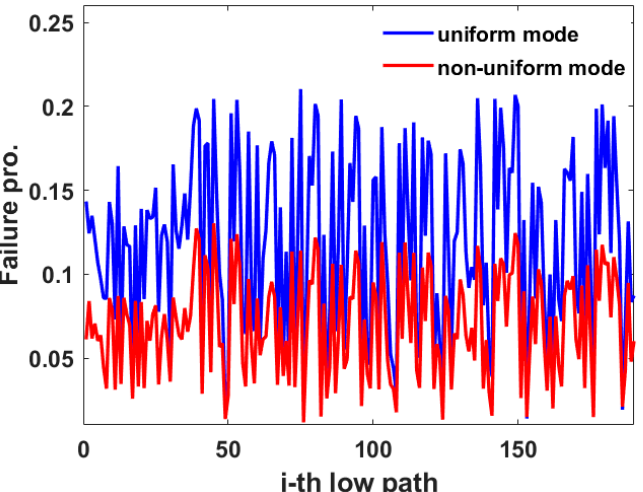
Figure 8. The simulation results of the lowest failure probability of any two nodes in the 20 communi- cation nodes.